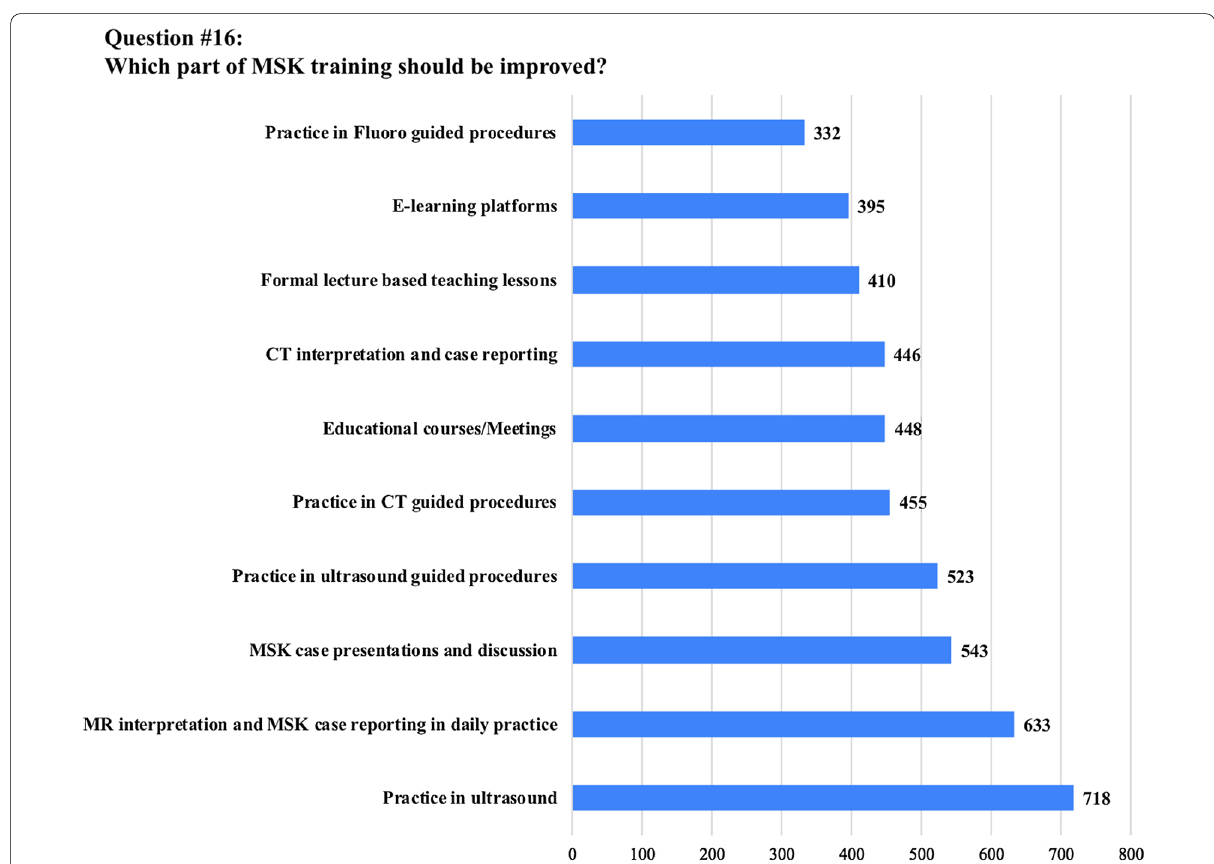
Fig. 5 Graphical representation of answer distribution to question #16: need for improvement of MSK training